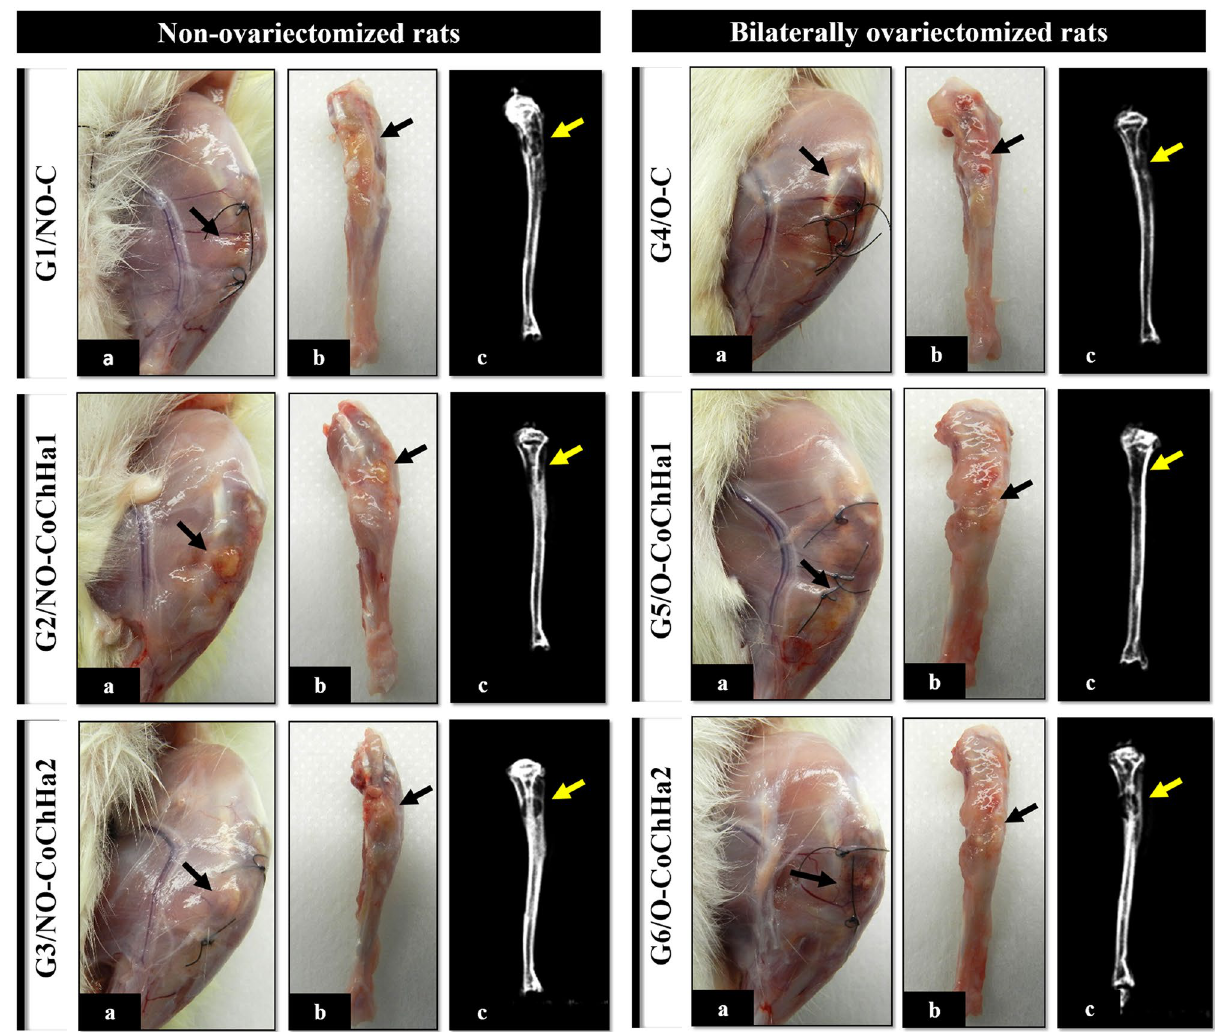
Figure 2. Macroscopic and radiologic images of the groups of non-ovariectomized and bilaterally ovariectomized rats. Note the absence of infections and bone rarefaction that would indicate an intense immune response to the scaffolds. ( a ) Macroscopic image of the defect area in the left tibia after induced painless death. ( b ) Macroscopic image of the dissected left tibia. ( c ) Radiographic image of the left tibia. The arrows indicate the bone defect area in the proximal metaphysis of the left